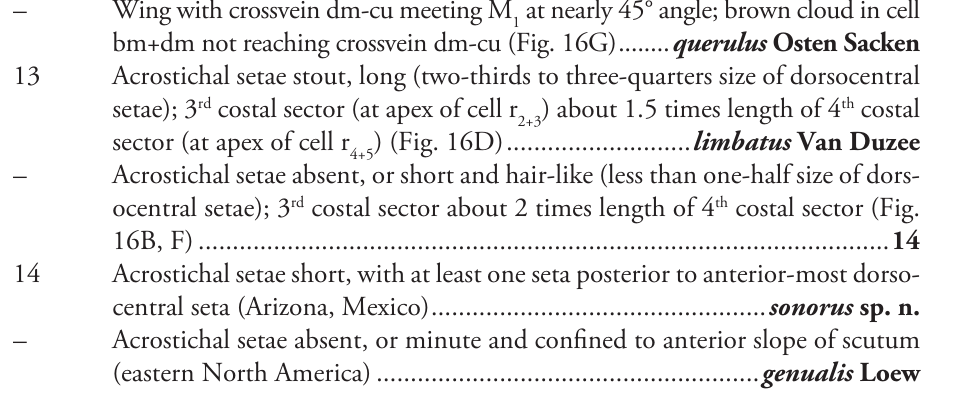
Figs 2A, 3C, 5A, 10A, 13, 16B Diagnosis. Males and females are distinguished by the absence of acrostichal setae and having only 1 presutural intra-alar seta. Males are further distinguished by having tarsus I with tarsomere 2 very short (Fig. 3C), cerci long (Fig. 2A), and wing as in Fig. 5A. This species is most similar to L. sonorus sp. n. but easily separated by the number of in- tra-alar seta ( L. sonorus have 2), the male wings (Fig. 5A–B), and distribution (Fig. 13). Redescription. Male. Body length 7.0–9.0 mm, wing length 6.5–7.5 mm. Head: Face narrowed below antenna, slightly widening toward palpus, green or blue with silver- gray pollen that is most dense along eyes and below frontoclypeal suture. Ommatidia near face slightly larger than remaining ommatidia. Vertex covered with silver pollen that is sparse medially revealing metallic green or blue ground color. Vertical setae on very small elevation; ocellar tubercle prominent with 2 large setae (slightly larger than vertical setae); with 2 postocellar setae which are two-thirds length ocellar setae; postocular setae approximately one-third size of vertical setae with about dorsal one-half black (approxi- mately 12 black setae), ventral half (approximately 15 setae) white and more slender and slightly longer than black postocular setae. Ventral postcranial hairs (beard) rather sparse, wholly white. Palpus black, covered with moderately dense silver pollen and long, dense, dark brown to black setae on basal half. Antenna black, first flagellomere about as long as wide, broadly pointed apically, arista inserted near midpoint of dorsal edge. Thorax: Scutum green to green-blue with moderately dense silver-gray pollen, with large red-bronze stripes between dorsocentral setae, and along intra-alar setae; medial stripe metallic pink; posterior slope of scutum bronze with lateral blue-green spots; scutellum bronze, with sparse silver pollen; notopleuron and postpronotum cov- ered with silver pollen, often with some blue-green reflections; scutum with acrostichal setae absent (sometimes with a few small hairs on anterior slope of scutum); 6 dorso- central setae, 2 notopleural setae, 1–2 strong, black postpronotal setae (often a few smaller white hairs), 1 presutural intra-alar seta (the posterior-most seta near